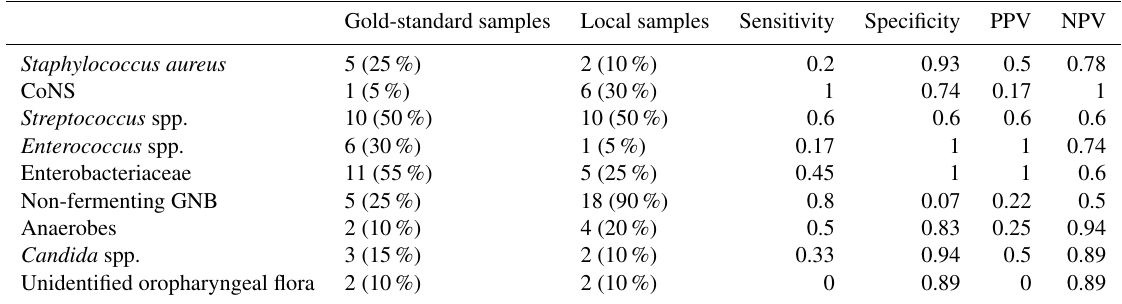
Table 2. Diagnostic values of superficial samples in comparison with deep surgical samples (gold